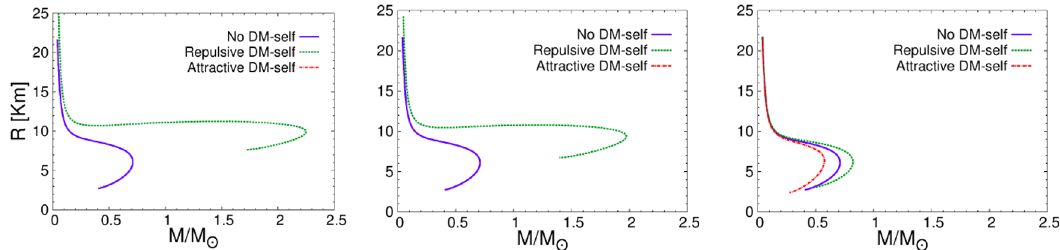
2 (cid:31) . Upper-Right panel: without DM self-energy. Low-middle 2 z 0 2 2 (cid:31) . 2 z 0 2